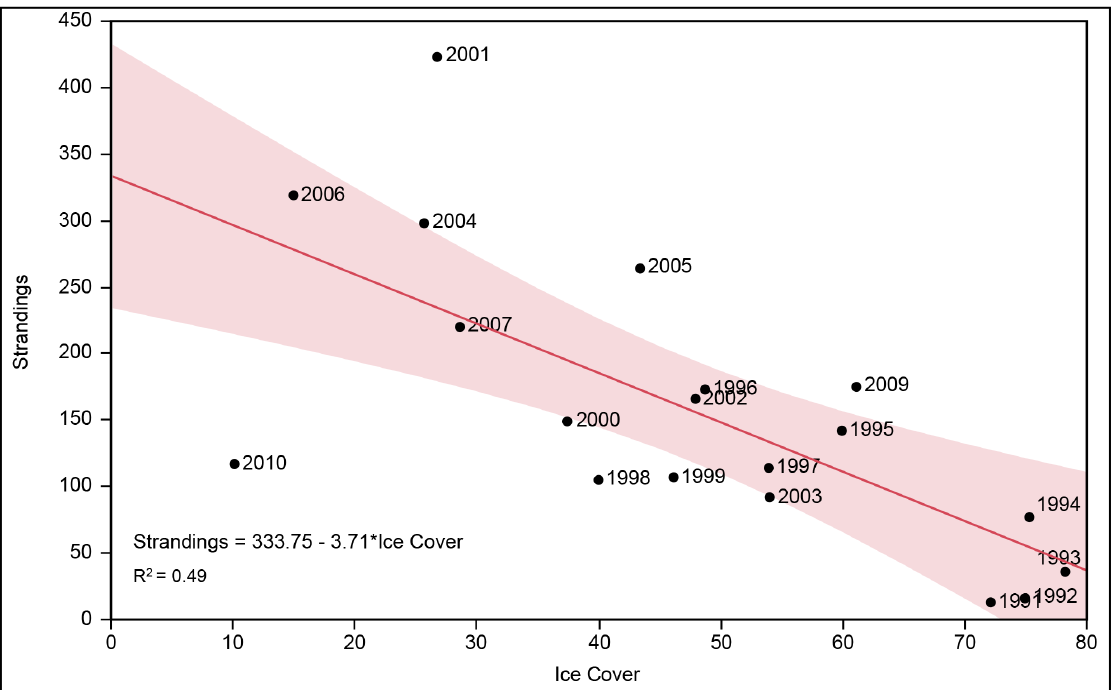
Figure 3. The relationship between percent sea ice cover and yearly harp seal strandings. The graph represents a linear regression between percent ice cover in February in the Gulf of St. Lawerence and yearly strandings along the Northeastern United States. The shaded area shows 95% confidence intervals.